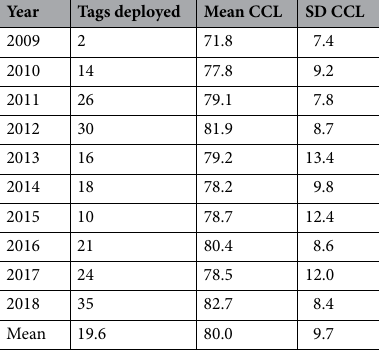
Table 1. Summary information for satellite tag deployments (CCL = curved carapace length from notch to